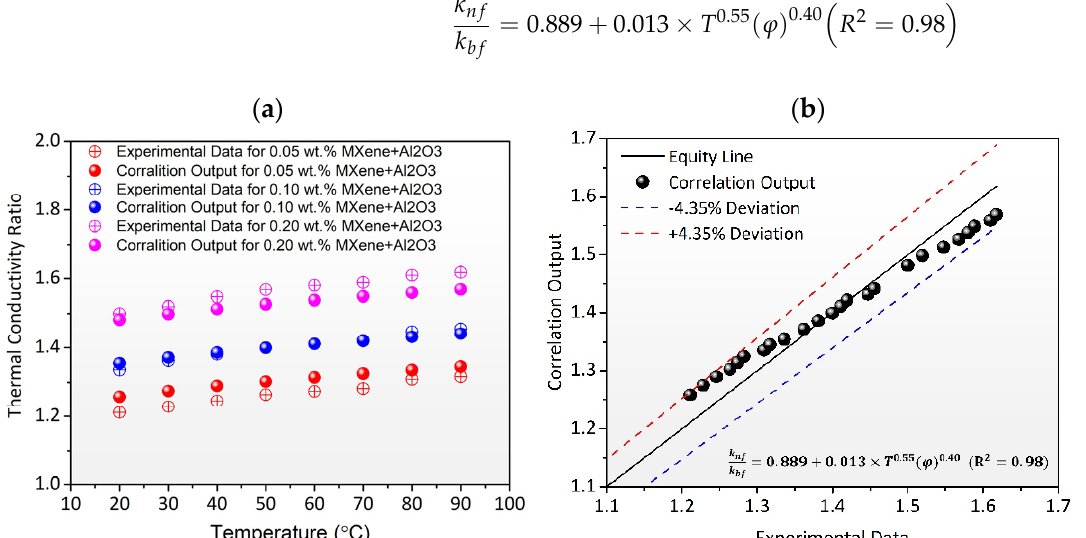
Figure 7. ( a ) Comparison between experimental TCR and correlation output as a function of temperature. ( b ) Correlation output vs. experimental TCR value with 4.35% deviation line.